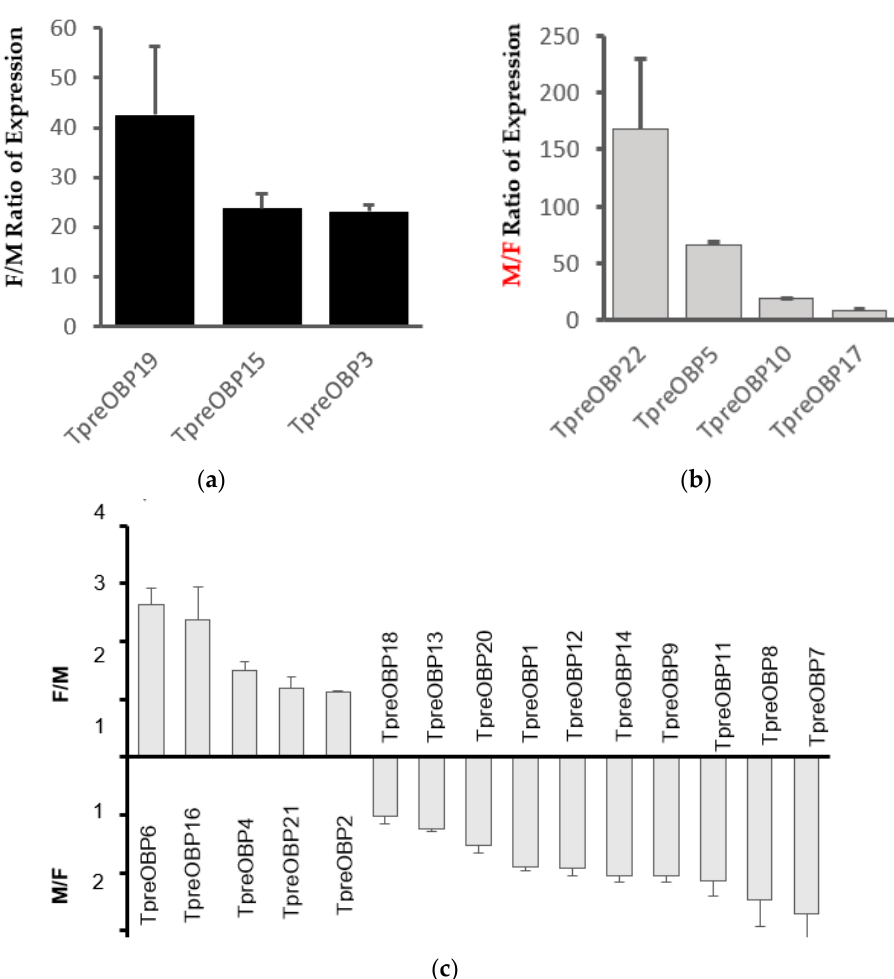
Figure 5. Quantitative real-time PCR (qPCR) analysis of T. pretiosum OBPs (TpreOBPs) from female and male adults. Normalised by TpreGADPH gene. ( a ), the female/male (F/M) expression ratios of TpreOBP19, TpreOBP5 and TpreOBP3, which are female-specific OBPs with F/M > 5. ( b ), the male/female expression ratios of TpreOBP22, TpreOBP5, TpreOBP10 and TpreOBP17, which are male-specific OBPs with M/F > 5. ( c ), other TpreOBPs that are expressed in both male and female adults with F/M or M/F ratios were less than 5.0. Error bars show standard deviation. M, adult males and F, adult females.